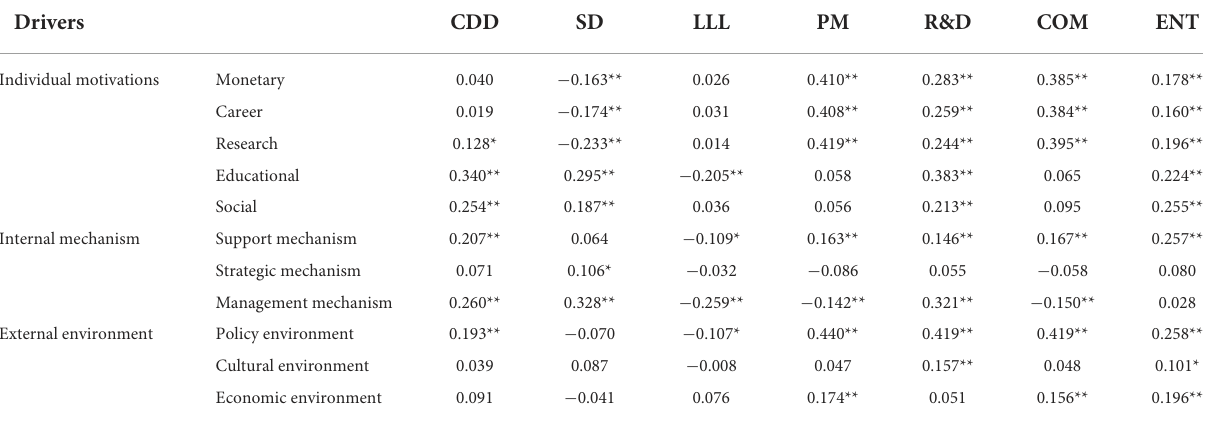
TABLE 1 Results of correlation